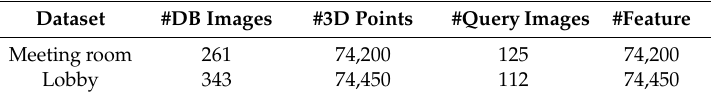
Table 1. The indoor databases used for the